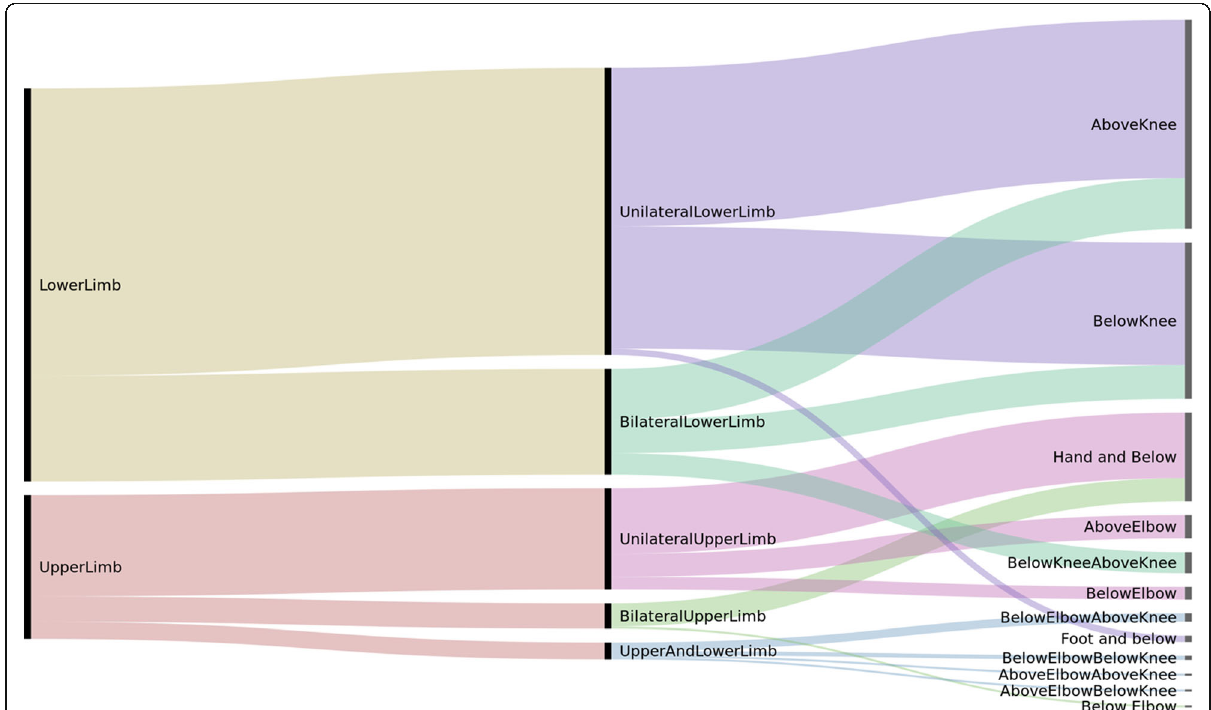
Fig. 3 Frequency of amputations by classification and anatomical location ( N = 254). * N = 254. The alluvial flow diagram shows how the general category (lower limb and upper limb left side) contains parts of finer classification, moving towards the right. The bold vertical lines indicate relative frequency. The colour code shows how each category moves into sub-categories, but change colour in the next